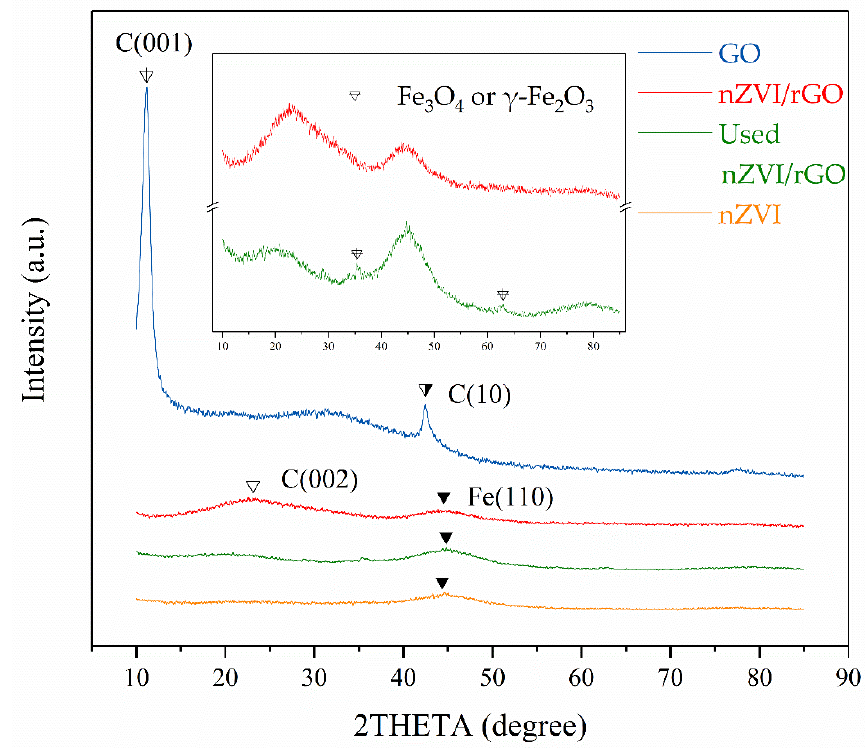
Figure 5. XRD patterns of GO, nZVI, nZVI/rGO, and the used